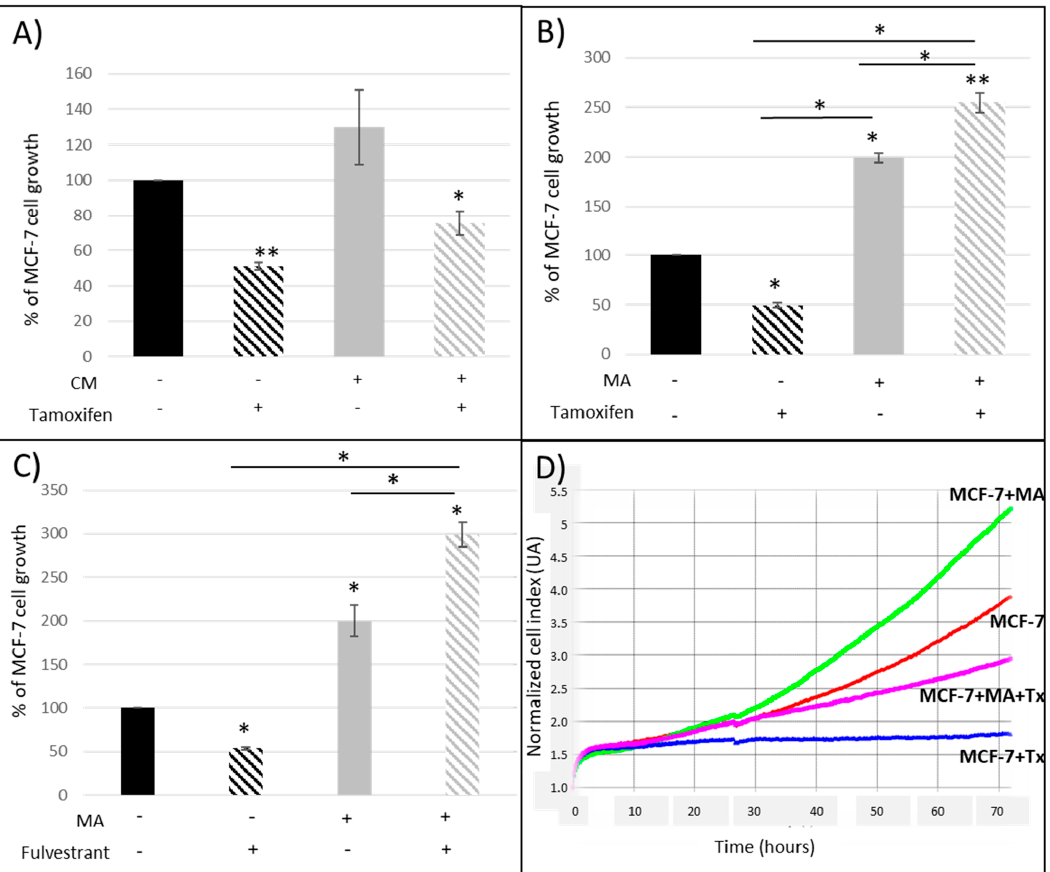
Figure 1. Percentage of MCF-7 cell proliferation when ( A ) cells were cultured with conditioned media (CM) obtained from the culture of human mature adipocytes (MA) and tamoxifen (Tx); ( B ) cells were co-cultured with MA and Tx; ( C ) cells were co-cultured with MA and fulvestrant. ( D ) Representative graph from iCELLigence system. Results are expressed as percentage of MCF-7 cell growth ± SEM at 72 h post-treatment ( n = 3, * p < 0.05, ** p < 0.01). [CM: conditioned medium; MA: mature adipocytes].